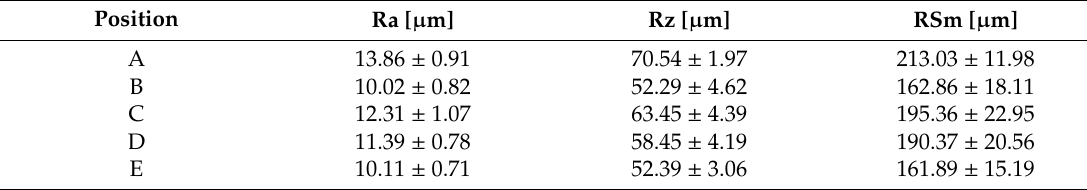
Table 7. The mean and standard deviation for roughness parameters.